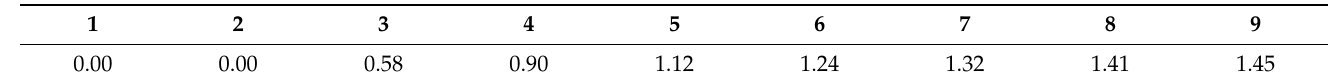
Table A3. Average random consistency index RI value